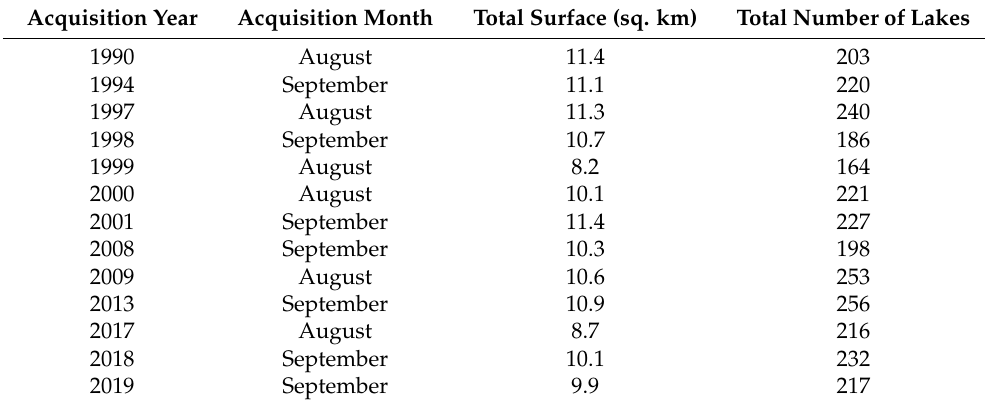
Table 3. The table shows the surfaces (sq. km) and the number of lakes extracted from each